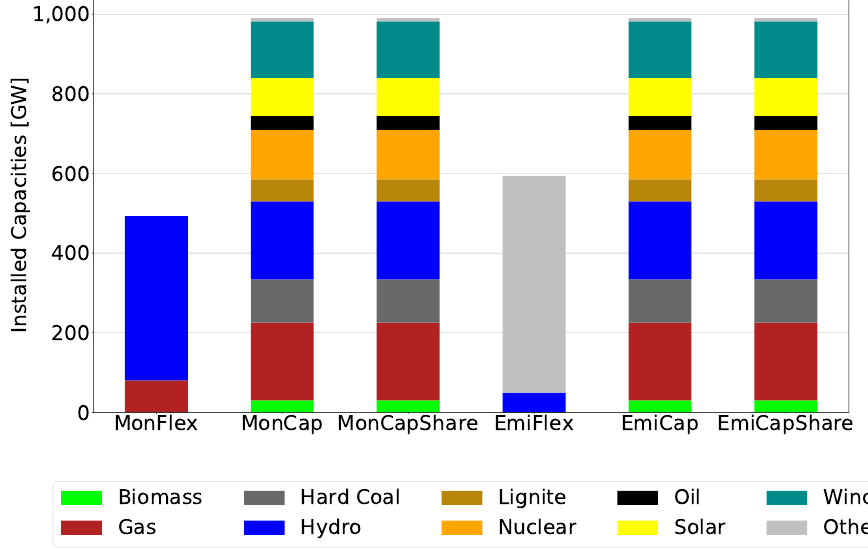
Figure 4. Comparison of installed capacity by fuel group and